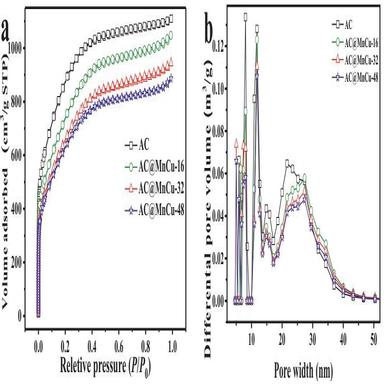
(a) N2 adsorption-desorption isotherms and (b) pore size distribution of four carbon materials.